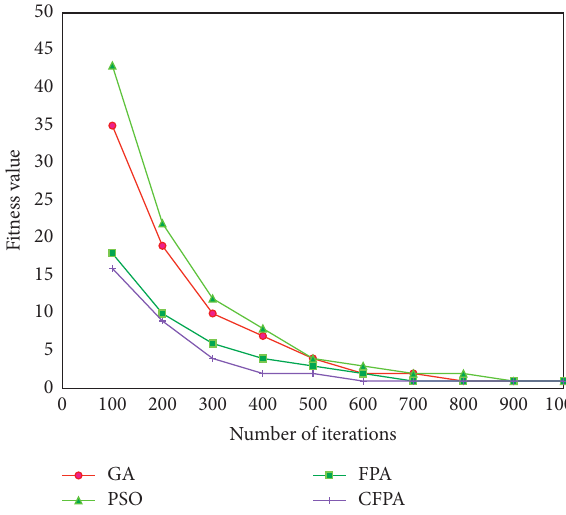
Figure 3: Four algorithms for fitness value under f 2 function.